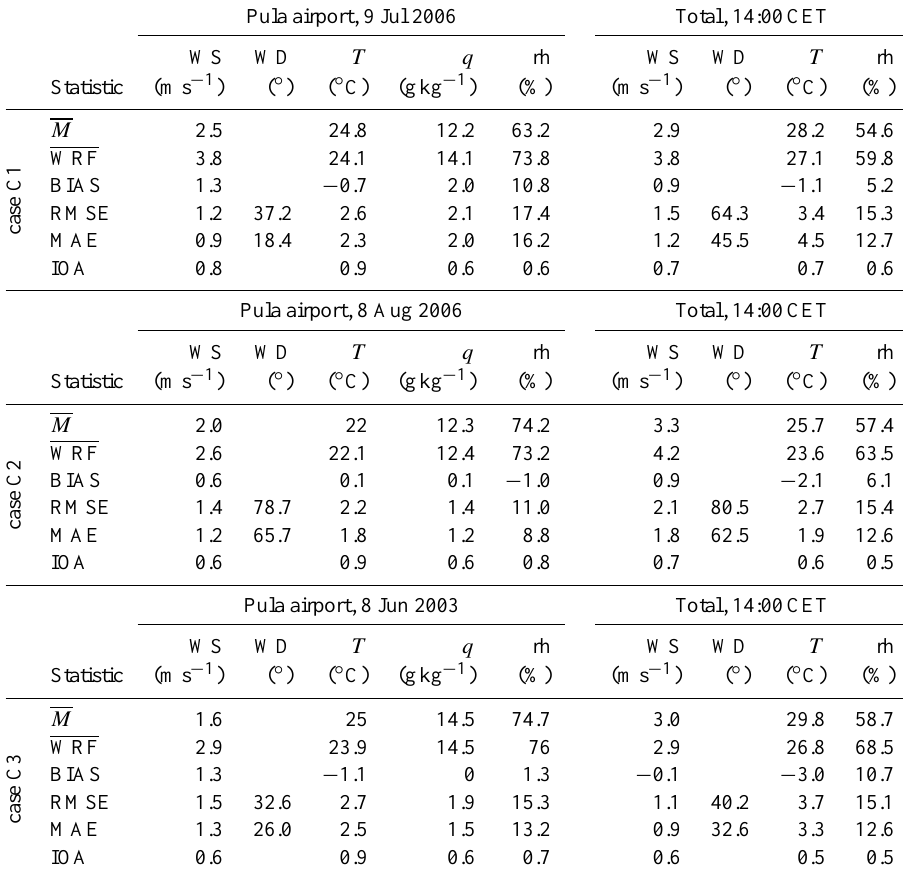
Table A1. Some statistics for numerical simulations of cases C1 to C3 – mean measured and modelled values, BIAS, root mean square error (RMSE), mean absolute error (MAE), and the index of agreement (IOA). A comparison was done for 10m wind speed (WS; ms − 1 ) , wind direction (WD; deg), 2m temperature ( T ; ◦ C), humidity mixing ratio ( q ; gkg − 1 ) and relative humidity (rh; %). For Pula airport, statistical indices were calculated for the time series of wind and temperature for cases C1–C3. In the table, total represents spatial comparison between model data and data from stations in Fig. 1 at 14:00CET in three chosen